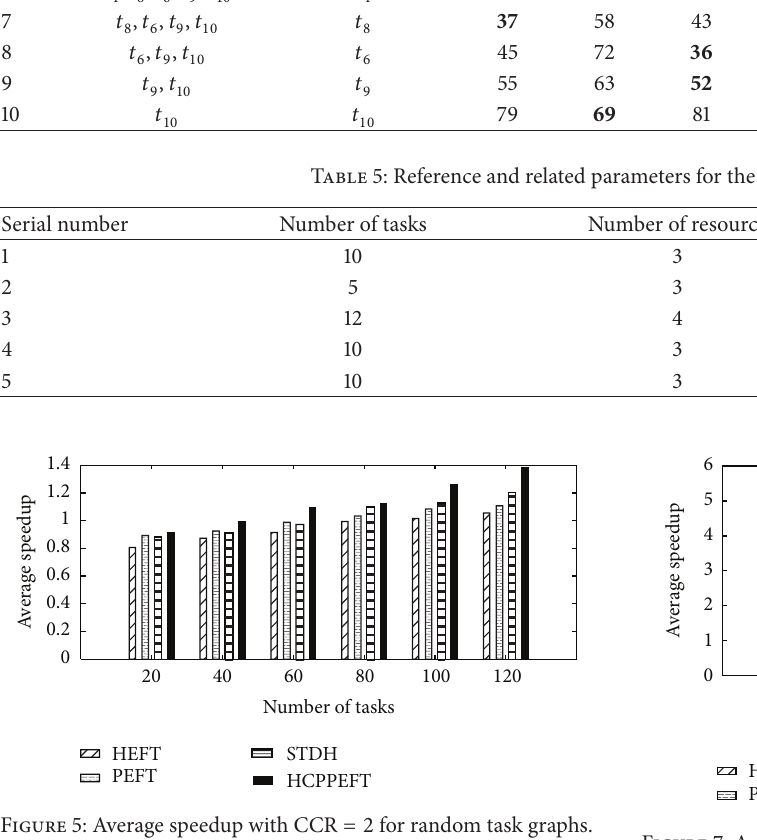
Figure 7: Average speedup with 100 nodes for random task graphs.